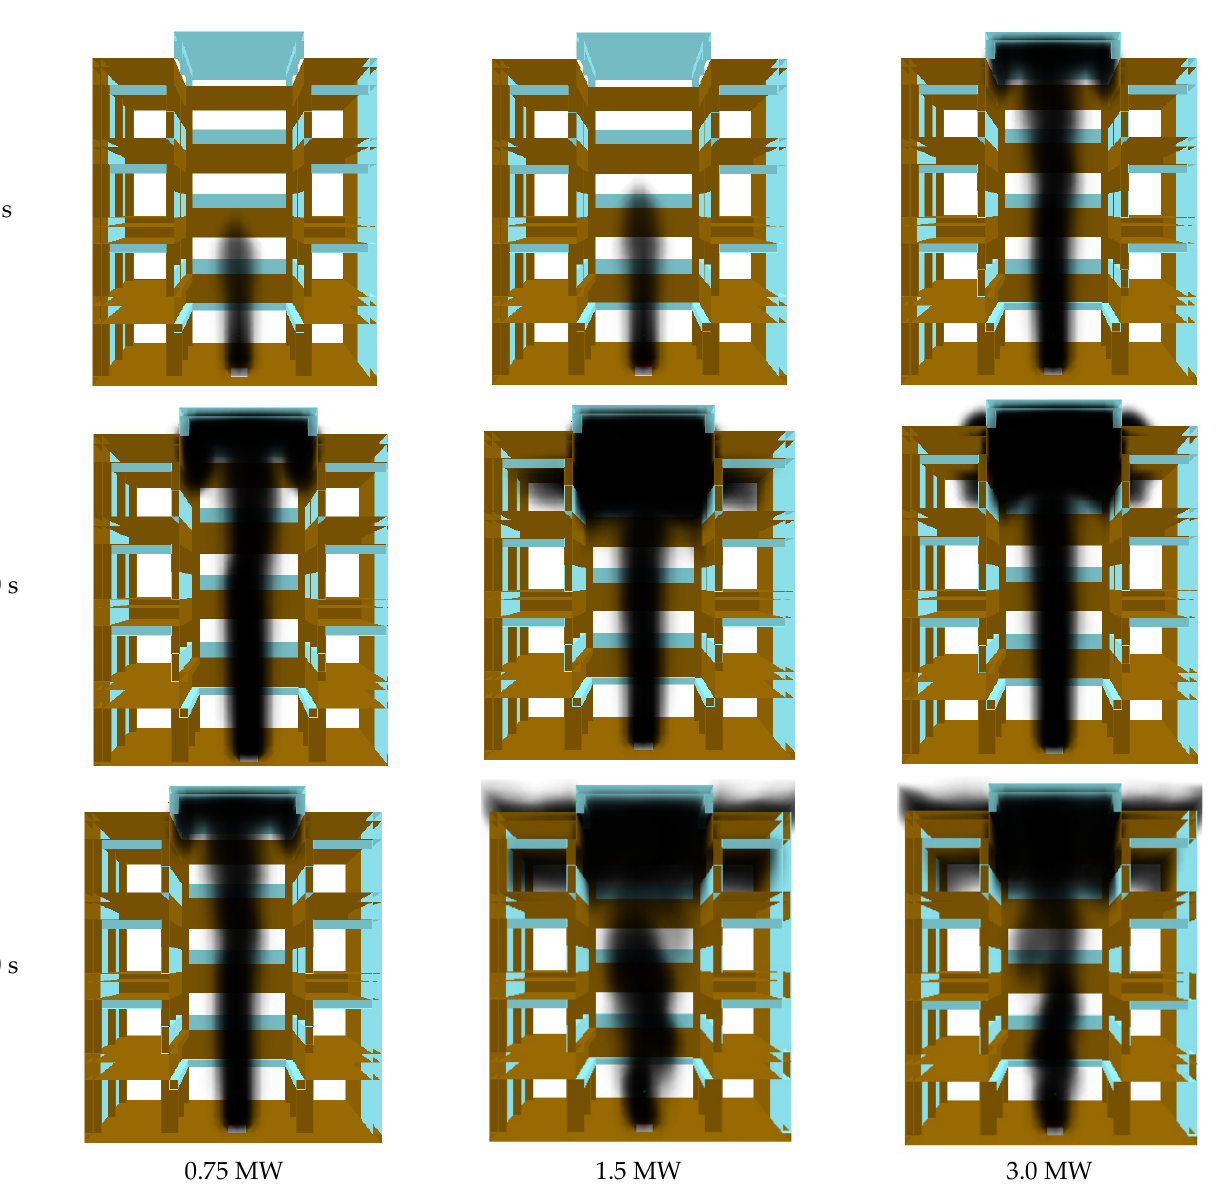
Figure 3. Diagram of the smoke spread of fire inside the atrium at different heat release rates and times.